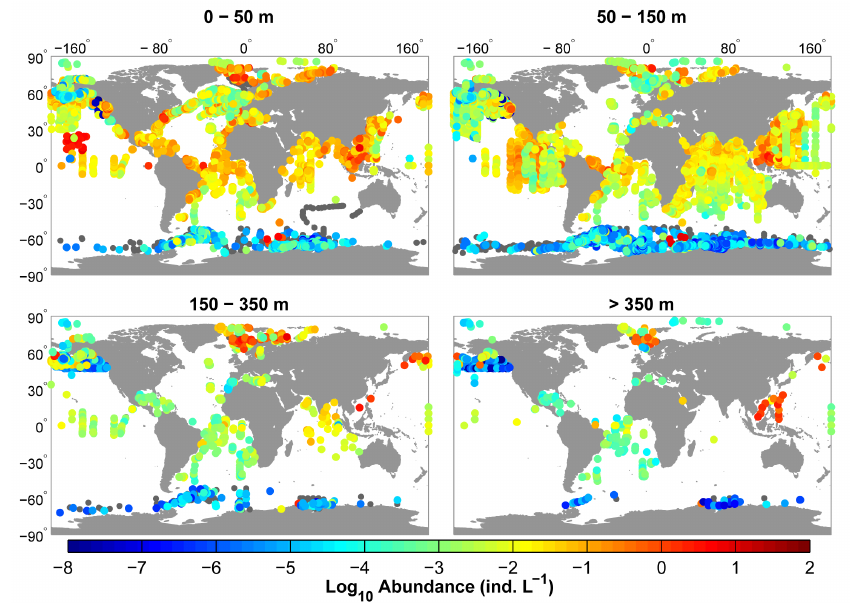
Figure 1. Global distribution of macrozooplankton abundance (ind.L − 1 ) at di ff erent depths. Grey points represent zero